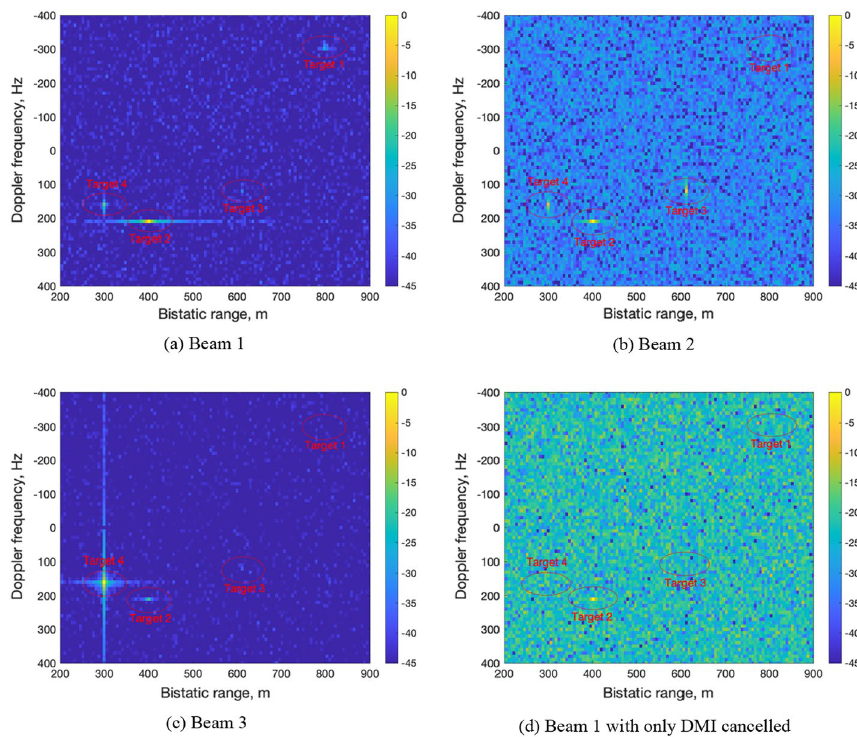
Fig. 5 Processing results by the